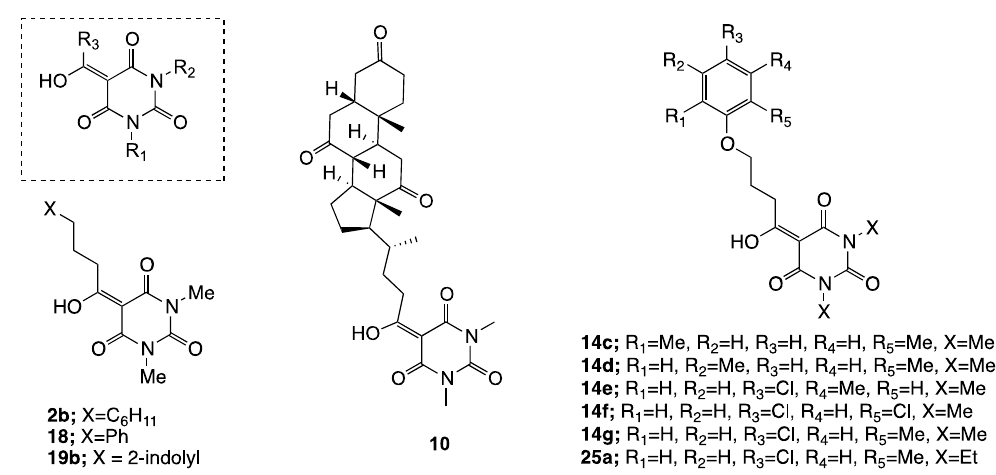
Figure 2. Structures with highest activity levels.